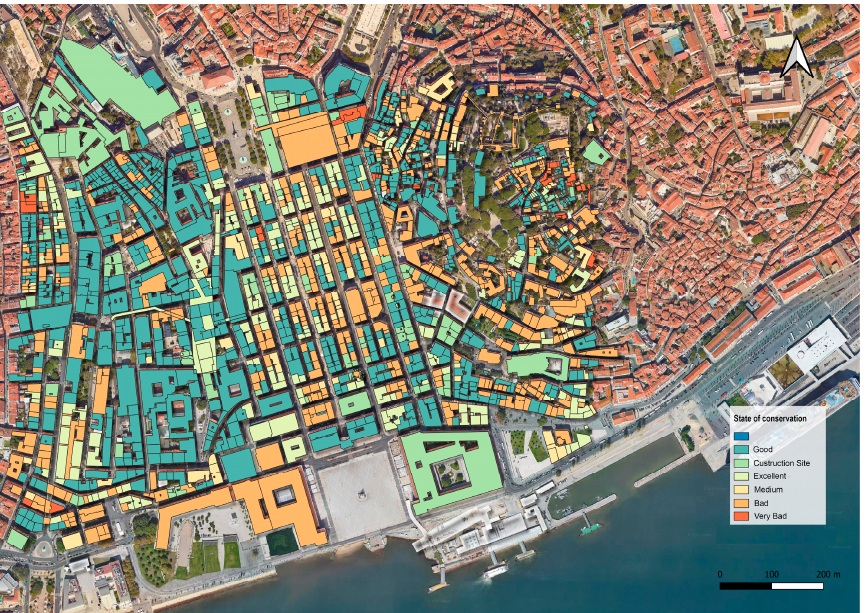
Figure 8. Number of floors for buildings in the historic center of Lisbon (adapted from Camara Municipal de Lisboa).